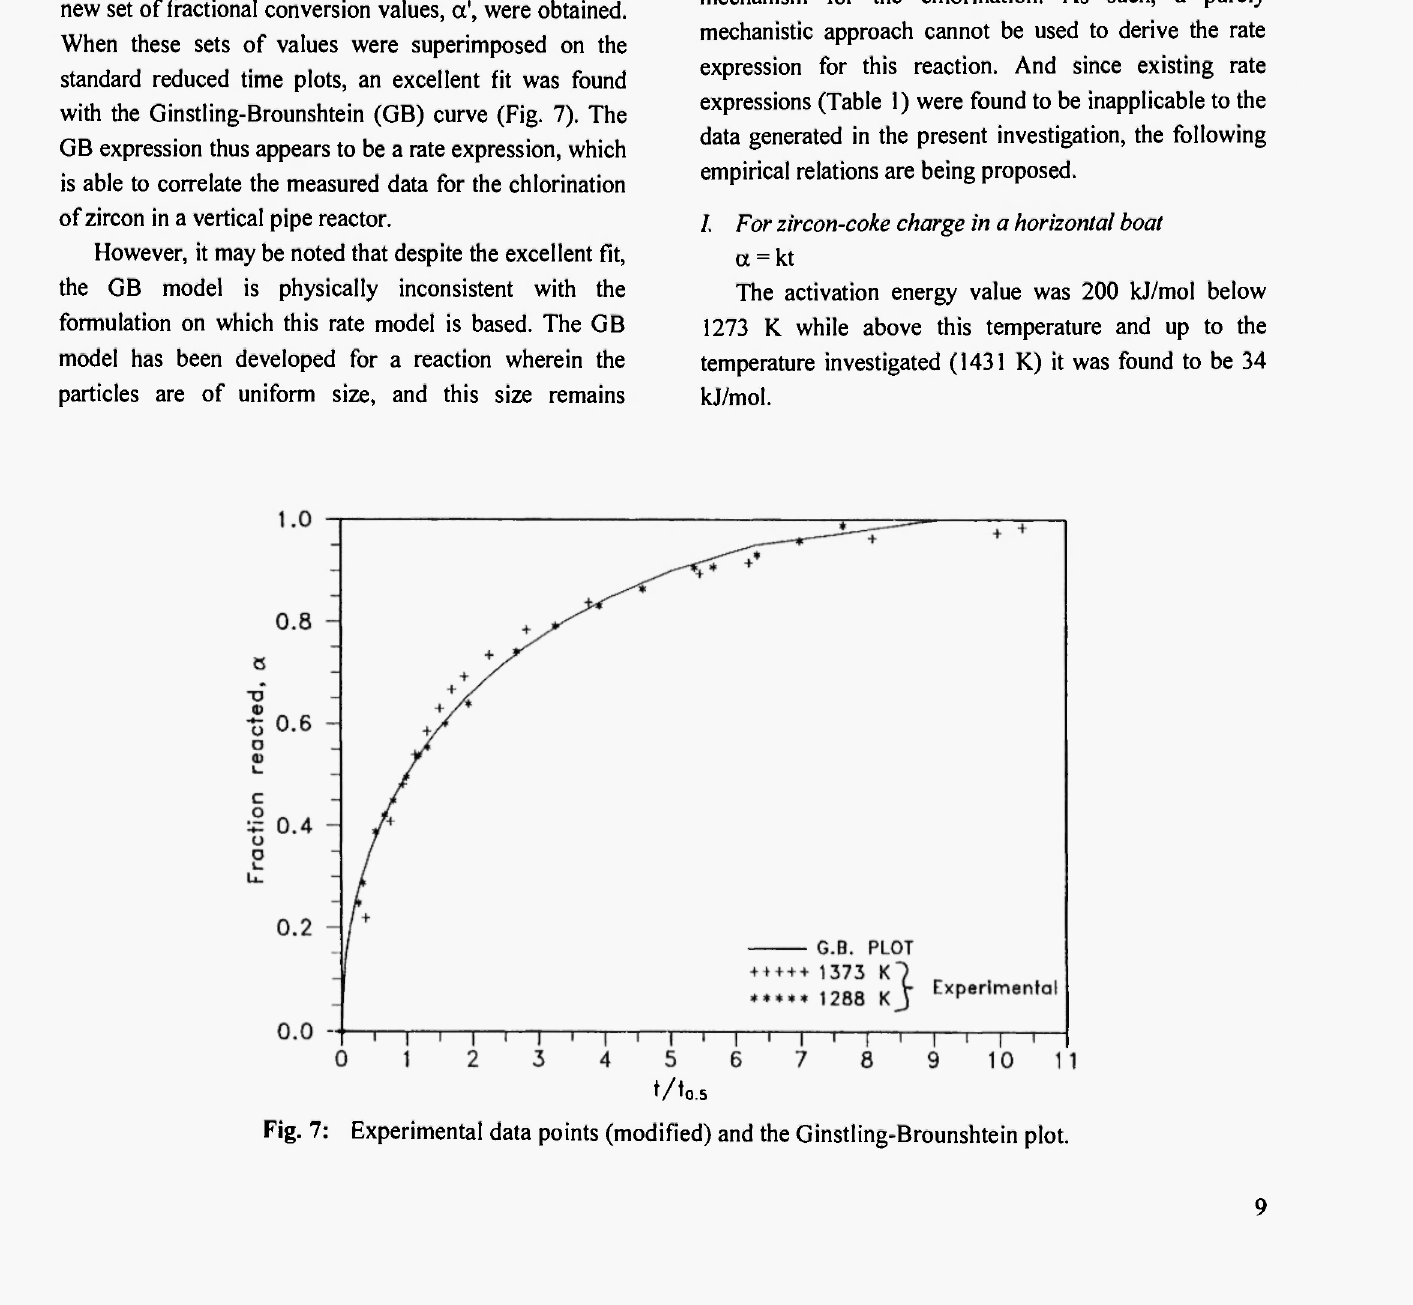
Fig. 7: Experimental data points (modified) and the Ginstling-Brounshtein